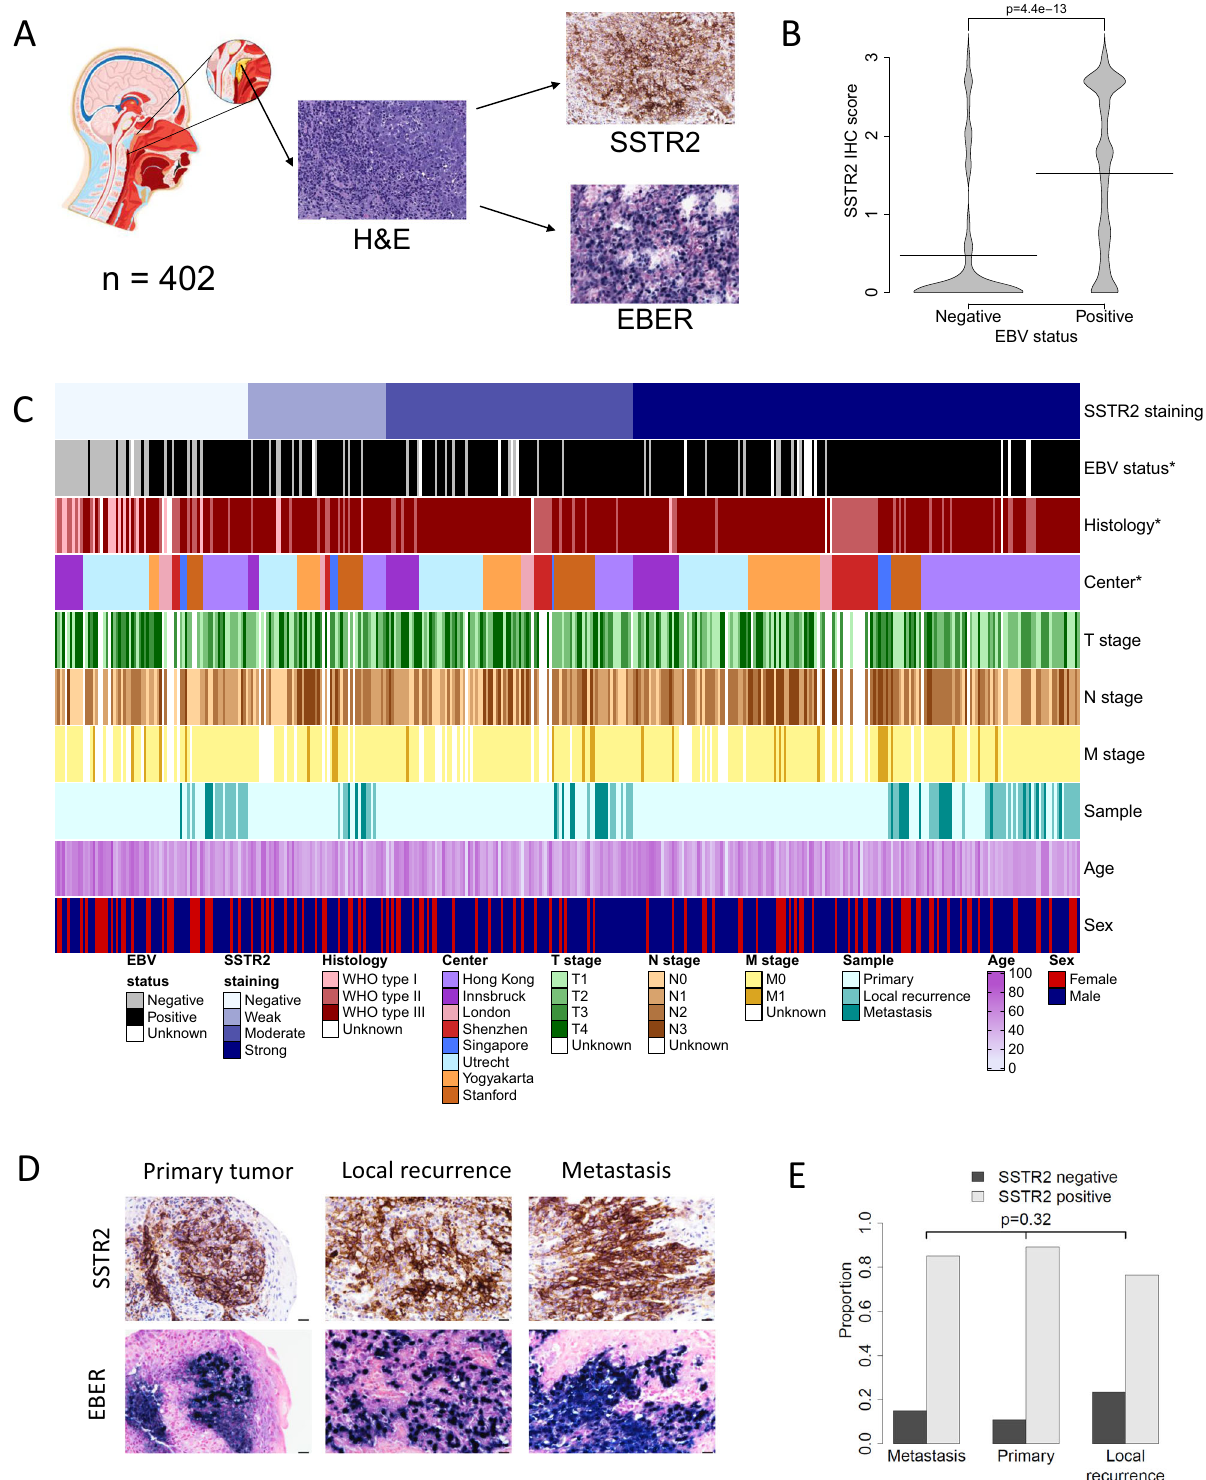
Fig. 1 Evaluation of SSTR2 expression in a multi-institution clinical cohort of NPC. a Anatomical localization and representative images of hematoxylin and eosin (H&E) stained histology, somatostatin receptor 2 (SSTR2) expression assessed by immunohistochemistry (IHC) and Epstein-Barr Virus (EBV)- encoded small RNAs (EBER) assessed by in situ histochemistry). b Beanplot of the SSTR2 IHC score in EBV-positive ( n = 278) and EBV negative ( n = 60) cases of NPC (W = 3085.5, p = 4.0e-14, Wilcoxon two-sided test). c Heatmap representation of the clinical annotations in relation to SSTR2 expression levels (asterisks indicate signi fi cant associations with SSTR2 expression using multivariate analysis). d , e SSTR2 status and EBV status were not statistically different in the primary ( n = 37), local recurrent ( n = 47), and metastatic ( n = 20) tumor tissue (images of rNPC42; ×400; scale bar 25 µ m and summary of data; two-sided Fisher ’ s test on proportion of SSTR2 positivity in primary, metastatic and local recurrence samples; p = 0.32). Representative tumor samples from a single patient are shown in d . Source Data are provided as a Source data fi